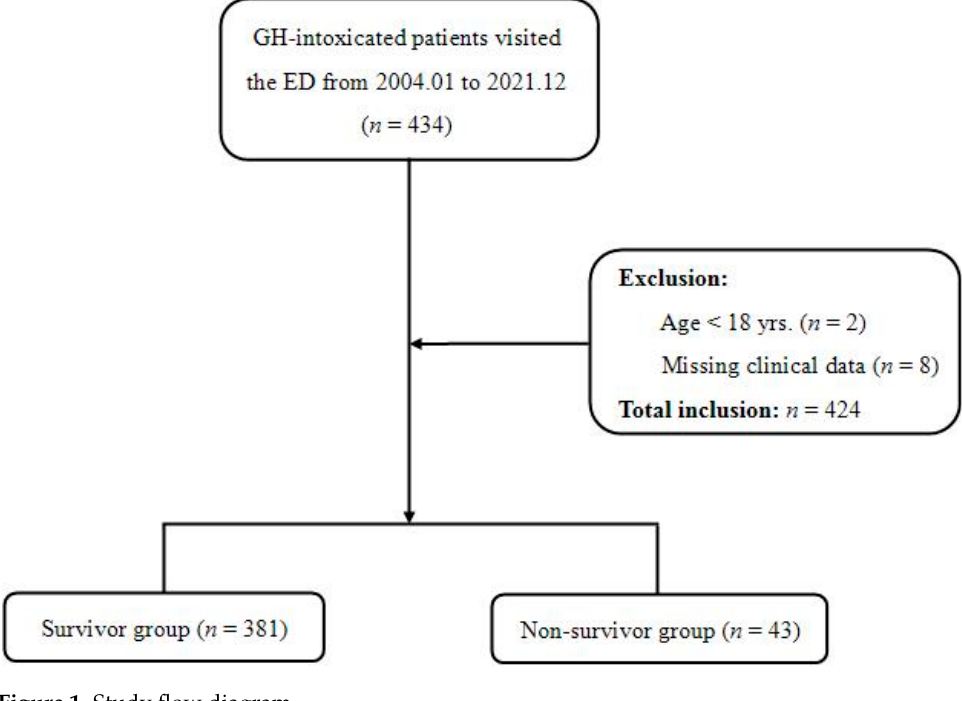
Figure 1. Study flow diagram.